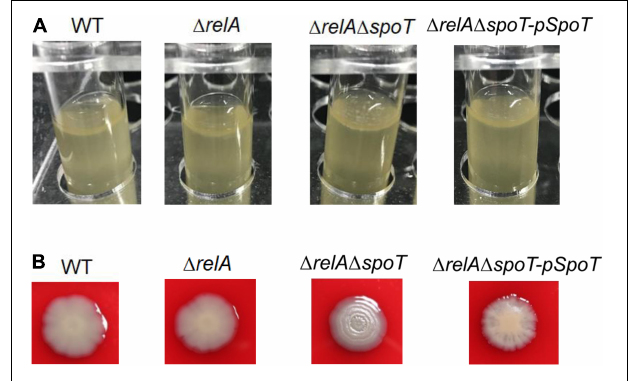
FIGURE 2 | The effects of relA and spoT on spotty pellicle and colony morphology. (A) Air-liquid interface pellicle formed by WT, (cid:49) relA , (cid:49) relA (cid:49) spoT , and (cid:49) relA (cid:49) spoT-pSpoT in the glass tube for 16 h at 30 ◦ C without shaking. (B) Colony morphologies of WT, its derivative and complemented strains. Three colonies of each strain were grown on a trypticase soy sheep blood agar plate for 24 h at 30 ◦ C. Three separate experiments were performed with biological triplicates each, and a representative image was